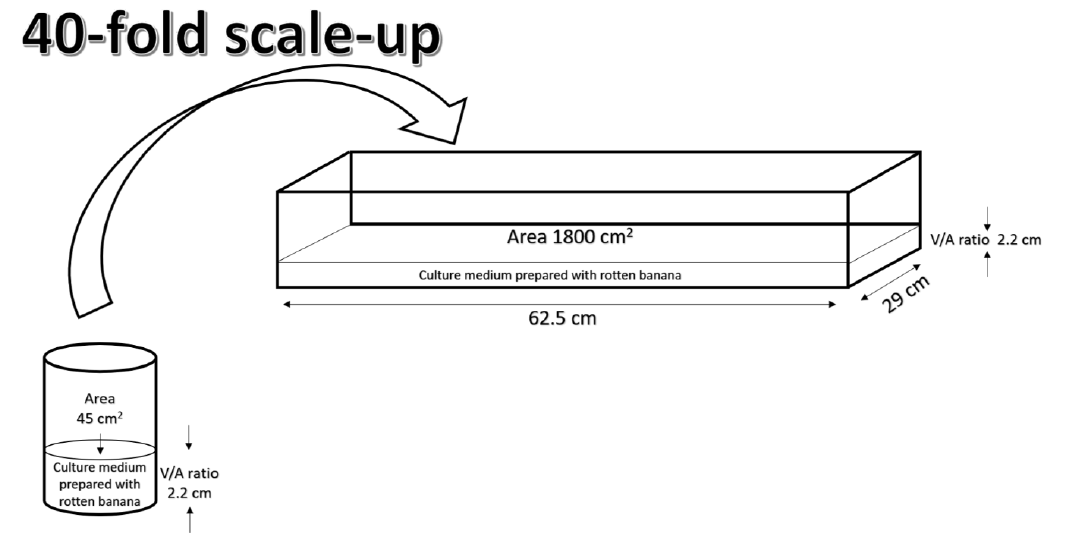
Figure 4. Sketch of the 40-fold scale-up developed in this study.